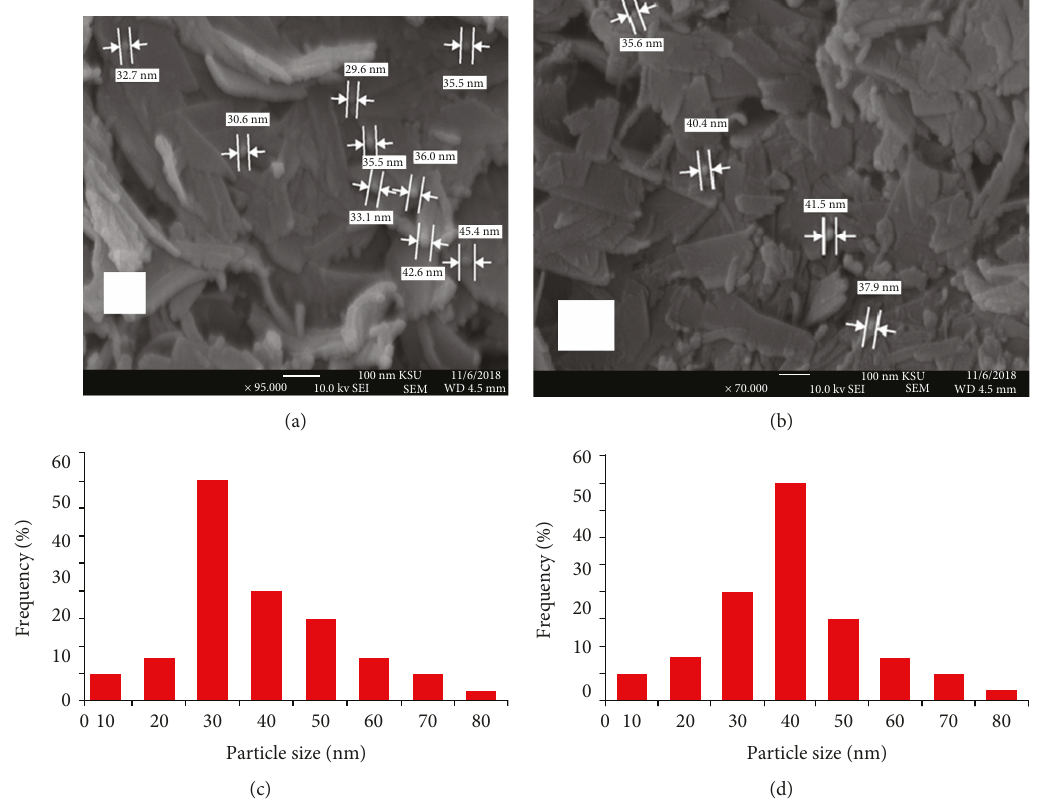
Figure 3: SEM images of (a) PVC containing 10wt% of Moringa oleifera oil and (b) Moringa oleifera oil/PVC-AgNPs. The particle size distribution and diameter were determined for (a) and (b) as shown in (c) and (d), respectively.